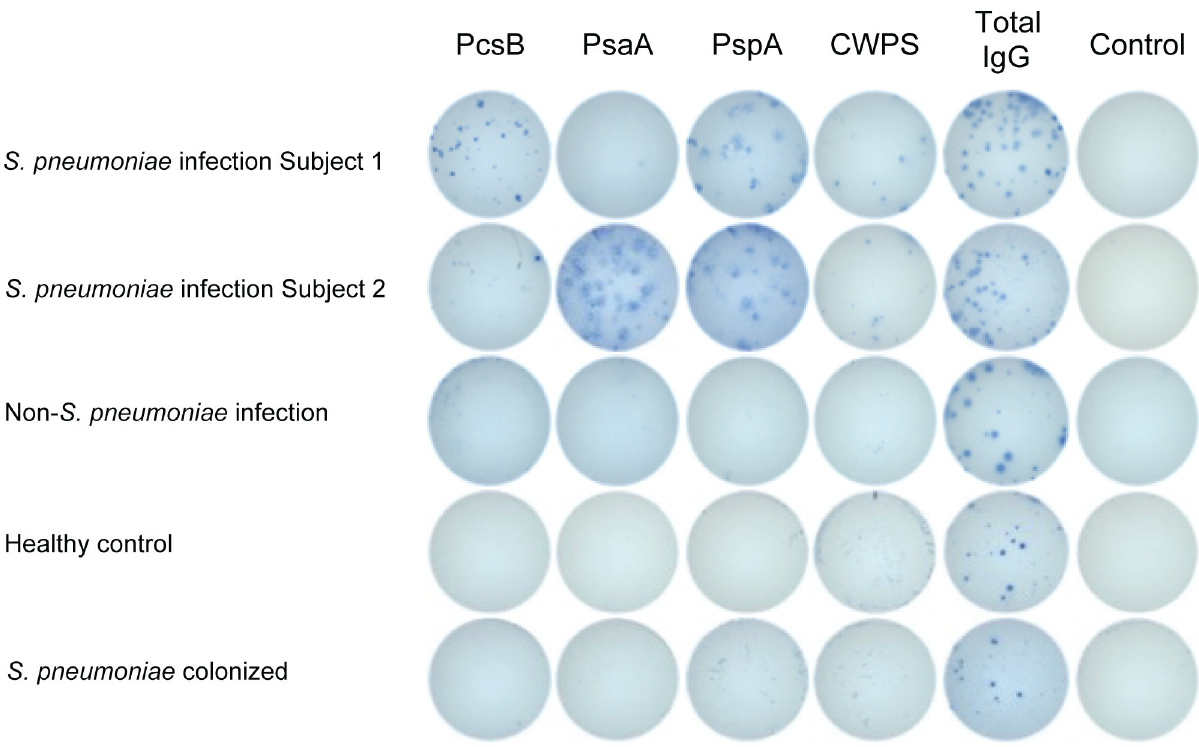
Fig 1. Representative ELISpot results. Peripheral blood mononuclear cells prepared from whole blood samples from five patients were tested in the ELISpot assay for antibody secreting cells producing antibodies specific for the antigens indicated at the top (PcsB, PsaA, PspA, CWPS) in the first four columns. Wells presented in the fifth column are coated with anti-IgG so they will detect any cell secreting IgG antibodies; wells in the sixth column are coated with only the blocking agent (2% BSA) so they detect only antibodies reactive with the wells in the absence of any specific antigen. The five patients are: 1,2) two with S . pneumoniae infections (top two rows; SP3 and SP10 from Fig 2A), 3) patient with infection caused by a non- S . pneumoniae pathogen (NSP5 from Fig 2A); 4) healthy control (H10 from Fig 2A); and 5) patient colonized by, but not infected with, S . pneumoniae (COL1, Fig 2A).